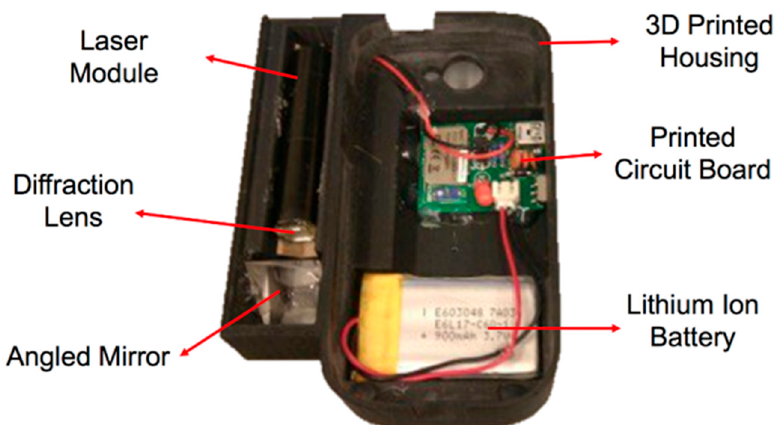
Figure 4. The DDRS enclosure, which holds the hardware add-on to power the laser module and communicates with the smartphone application via Bluetooth, the angled mirror to project the laser downward with the center dot visible at the center of the smartphone screen with the structured light system.